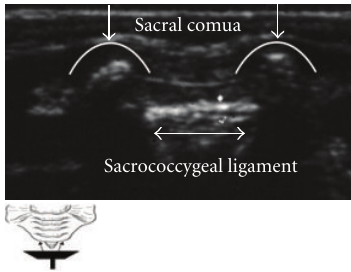
Figure 1: Placing the probe transverse plane at the coccyx, the sacral cornua (represented in white arrows heading down) are viewed laterally as humps. Sacral hiatus is located between an upper hyperechoic line, representing the sacrococcygeal membrane or ligament and an inferior hyperechoic line representing the dorsum of the pelvic surface of the sacrum (bidirectional sided arrow).